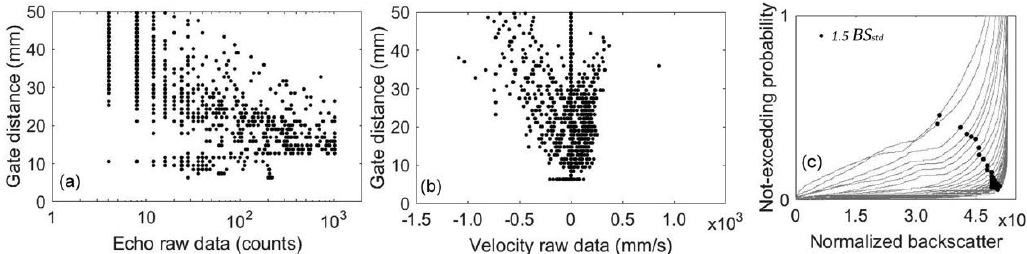
Figure 4. UVP analysis for a test with R c / H s = + 1. Profiles of raw echo intensity levels ( a ) and velocities ( b ), negative values are for inshore direction; the probability distribution of normalized backscatter ( BS n ) and corresponding threshold ( BS std indicated with dot marks) at each of the validated gates ( c ).